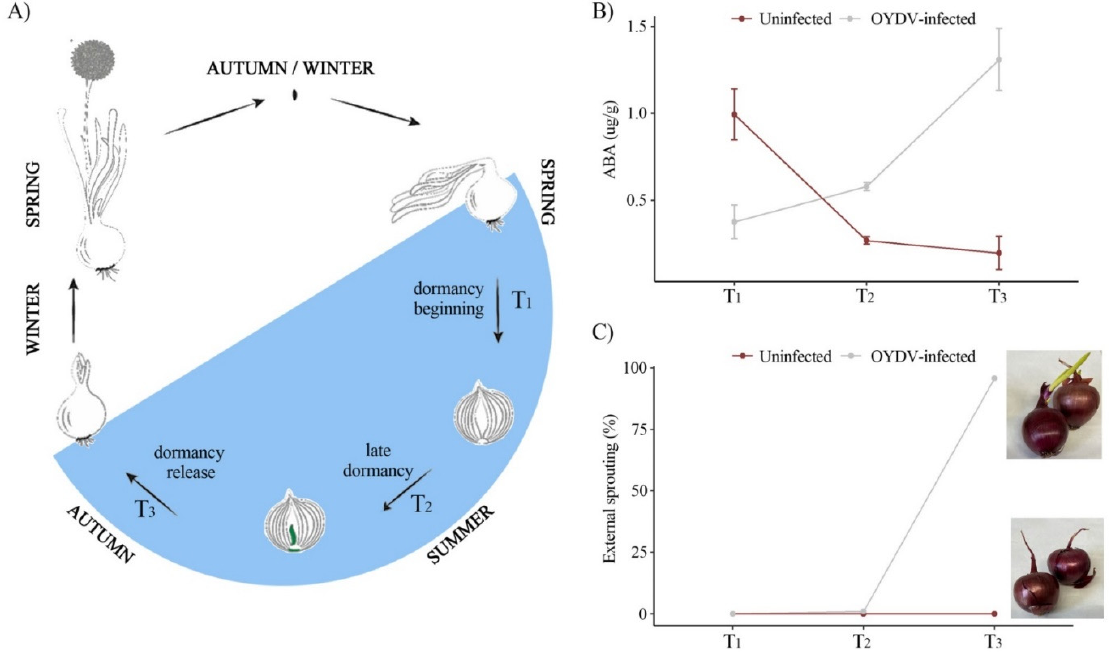
Figure 1. ( A ) Onion life cycle. The stages between the beginning of dormancy (T 1 ), the late dormancy (T 2 ), and the dormancy release (T 3 ) are highlighted (in light blue); ( B ) ABA concentration (µg/g) evaluated through HPLC/MS; and ( C ) sprouting (%) in uninfected and OYDV-infected plants at the three time points investigated.